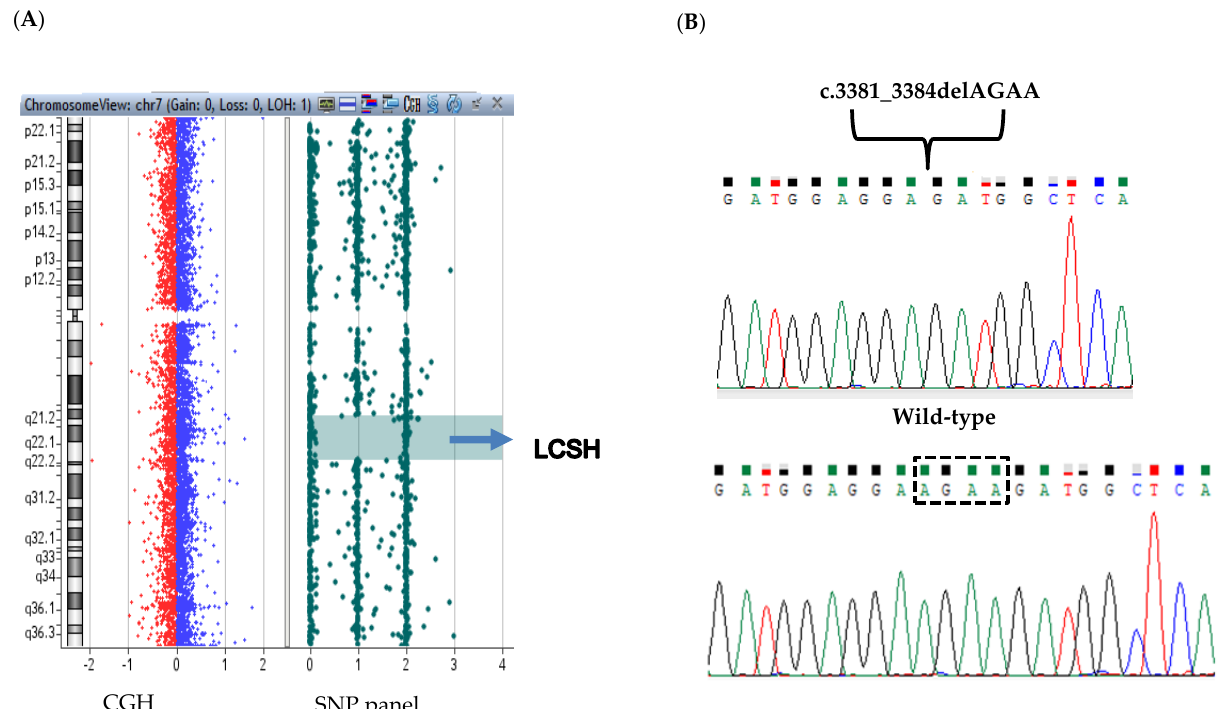
Figure 2. CGH-SNP array and sequencing results. ( A ) Array-CGH-SNP results: the LCSH on chromosome 7q21.13-q22.1 is indicated by a blue arrow. ( B ) The partial sequencing electropherogram is shown including the novel homozygous mutation identified in STAG3 (NM_001282716.1:c.3381_3384del); the corresponding wild-type sequence is shown below with a dashed rectangle showing the deleted bases.